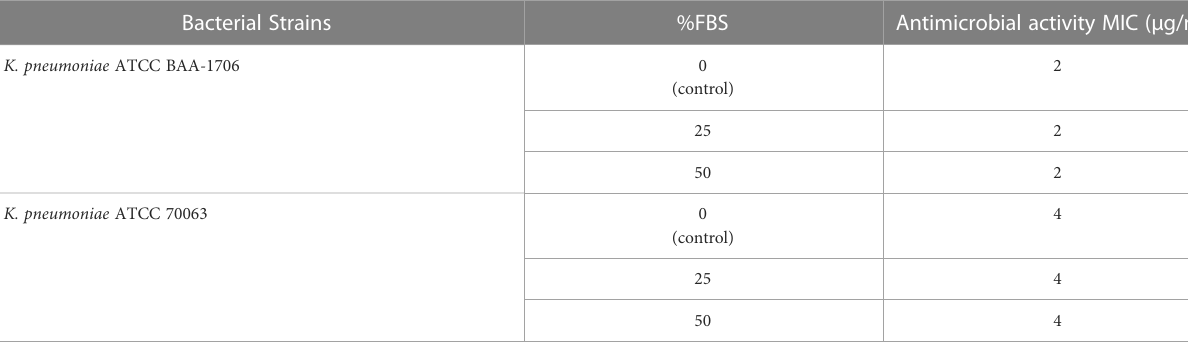
TABLE 6 The MIC values of the K11 against K. pneumoniae reference strains after FBS